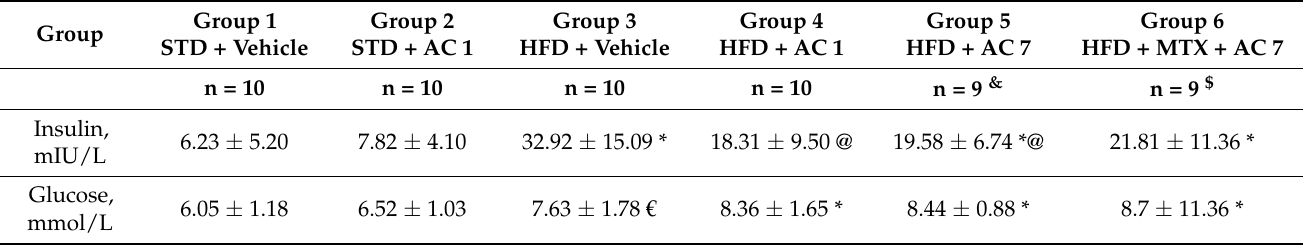
Table 5. Mean fasting insulin and glucose values on the day of euthanasia.